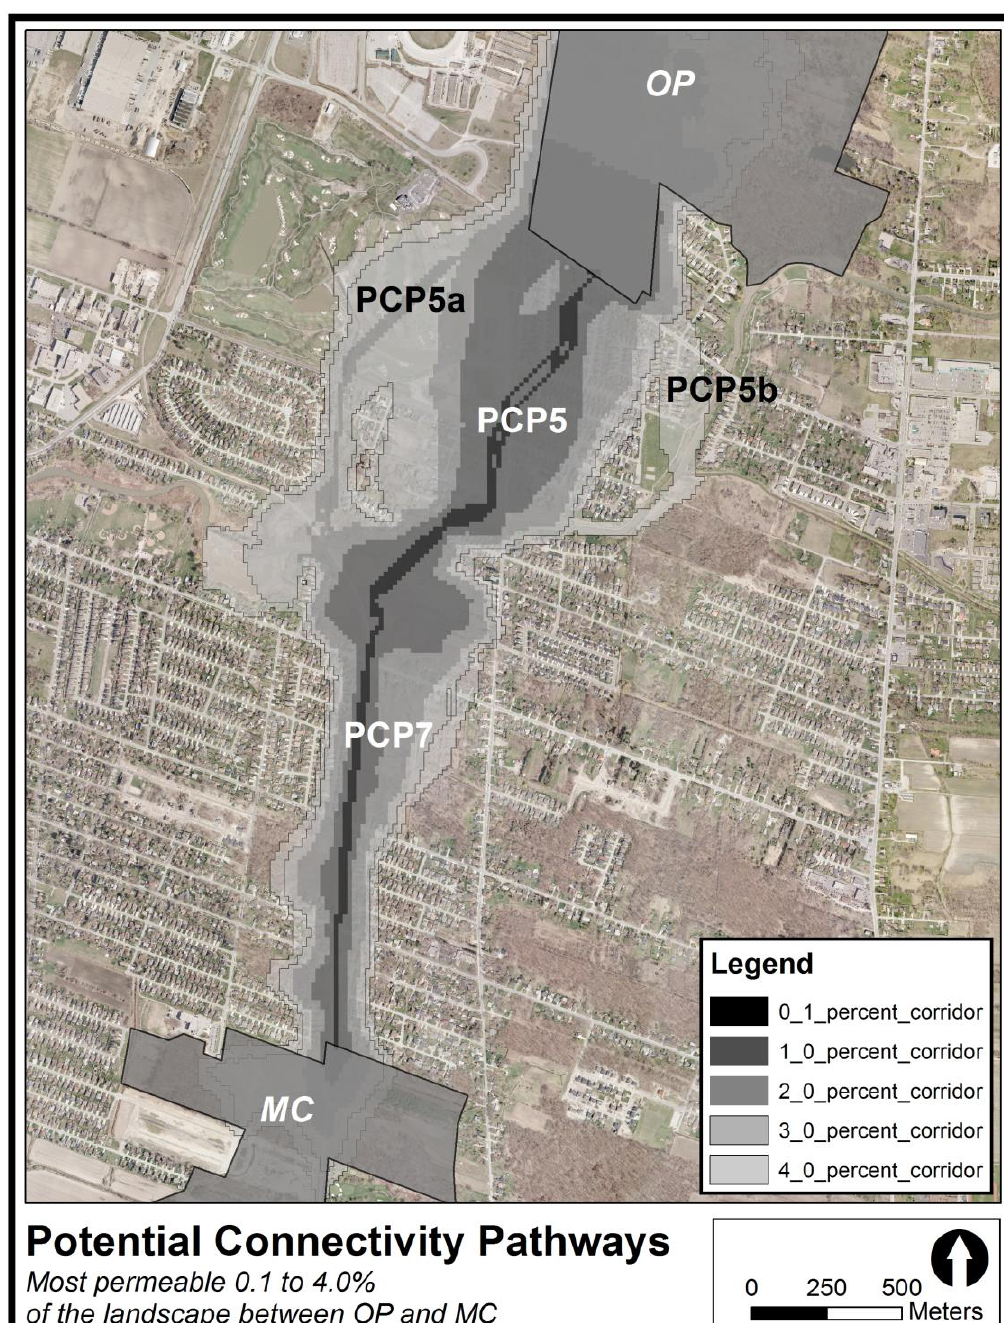
Figure 7. The most permeable 0.1% to 4.0% of the landscape between Ojibway Prairie (OP) and Marentette Drain Woodlots (MC) for the Massasauga rattlesnake in Windsor / LaSalle, Ontario as Marentette Drain Woodlots (MC) for the Massasauga rattlesnake in Windsor/LaSalle, Ontario as indicated by a cost-surface GIS indicated by a cost-surface GIS analysis.